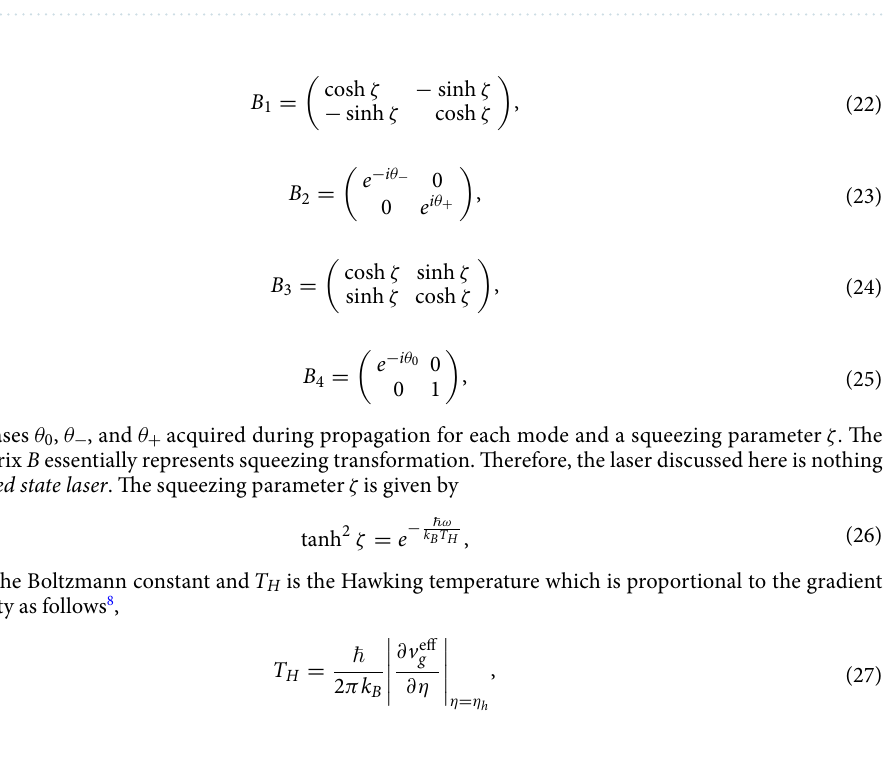
Figure 5. Sketch of the trajectories of modes. The solid (dashed) lines represent the mode with positive (negative) frequencies for antiparticles (particles). The dotted line is a virtual input mode for particles. The symbols are presented in the main